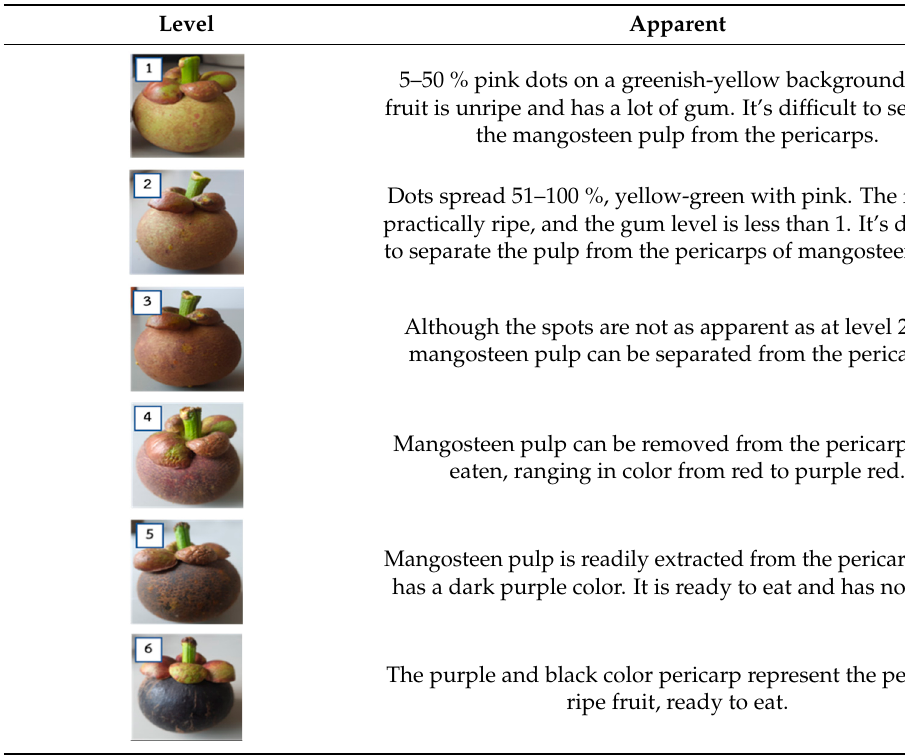
Table 2. The mangosteen ripening in all six